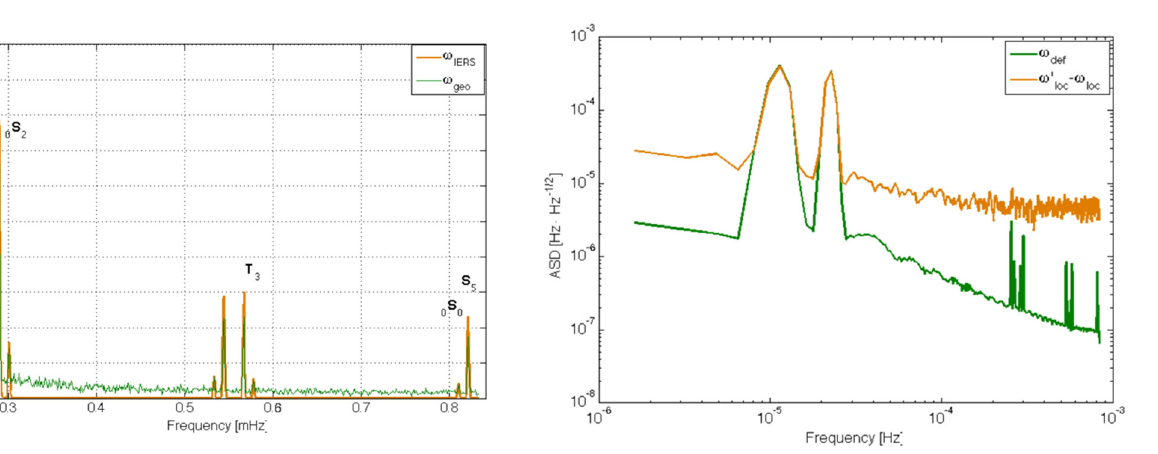
Fig. 6 ASD of (cid:3) def as expected by IERS and evaluated with the present